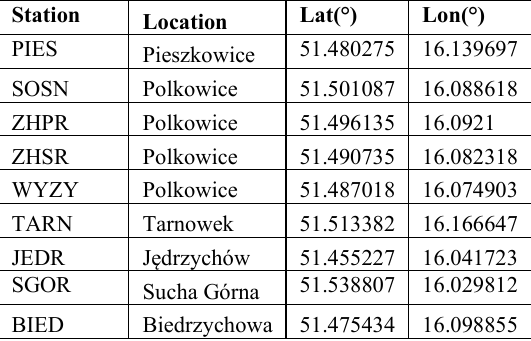
Table 2 . Location of GNSS